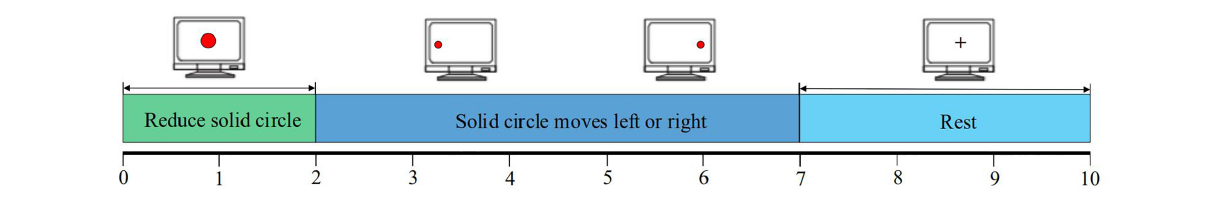
FIGURE 5 | Assessment paradigm before and after enhanced MI training.